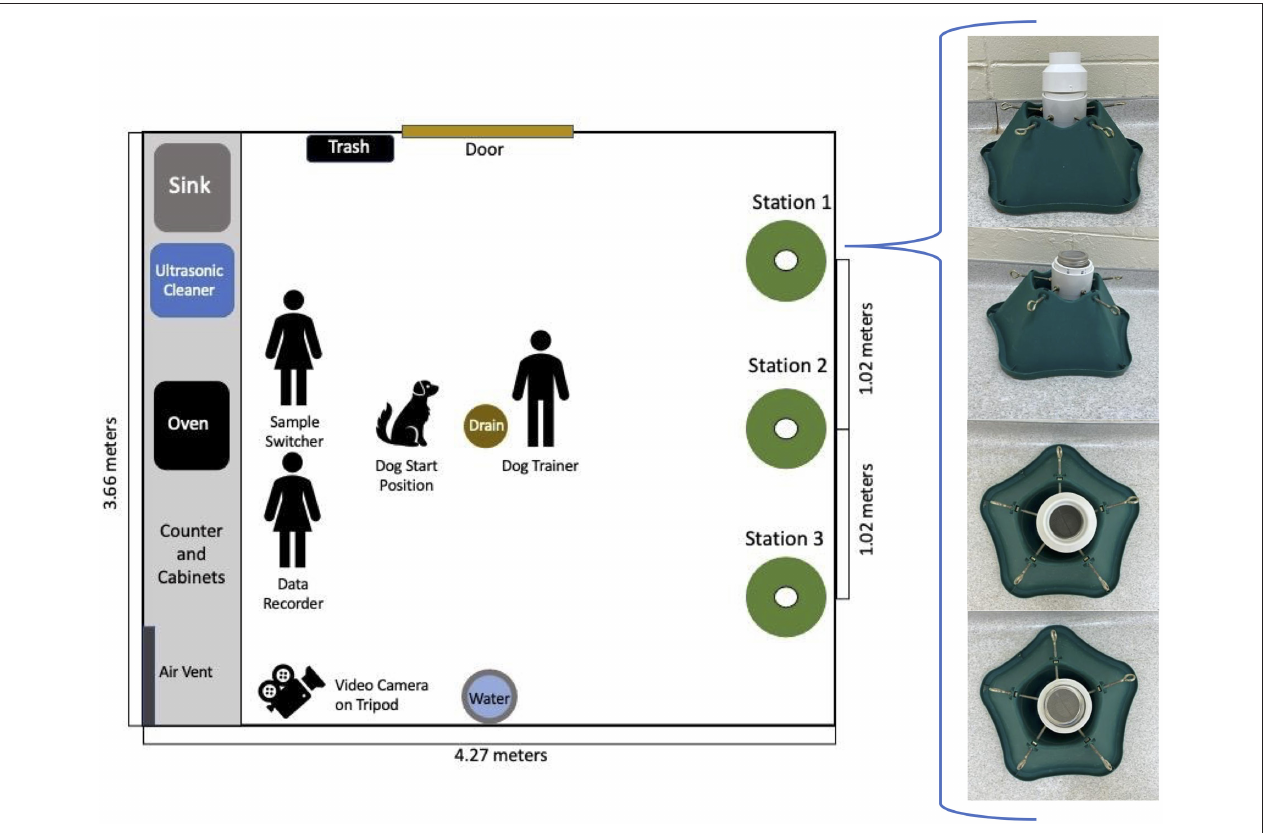
FIGURE 1 | Diagram of room where training and testing were conducted. The image depicts the location and composition of the structure that was designed for this